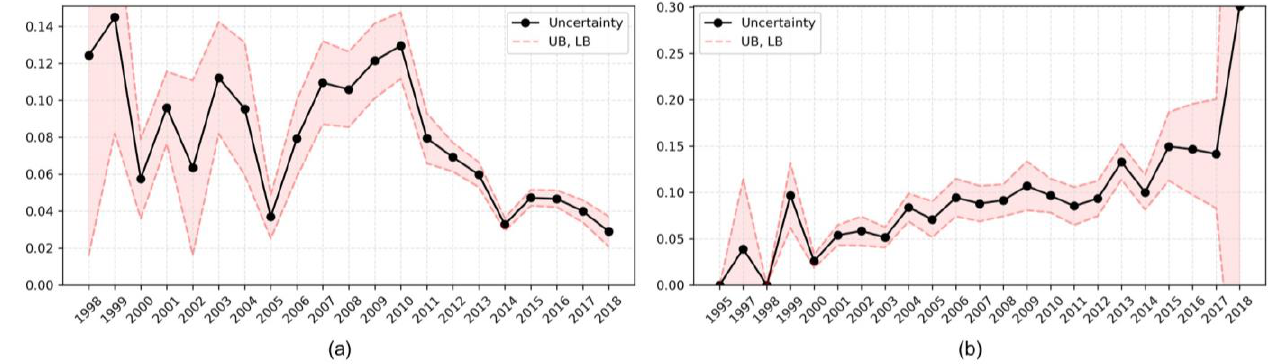
Figure 4. Visualization of trends in uncertainty over time. ( a ) Results for technologies evaluated as ‘Low’ in actual value; ( b ) Results for technologies evaluated as ‘High’ in actual value.